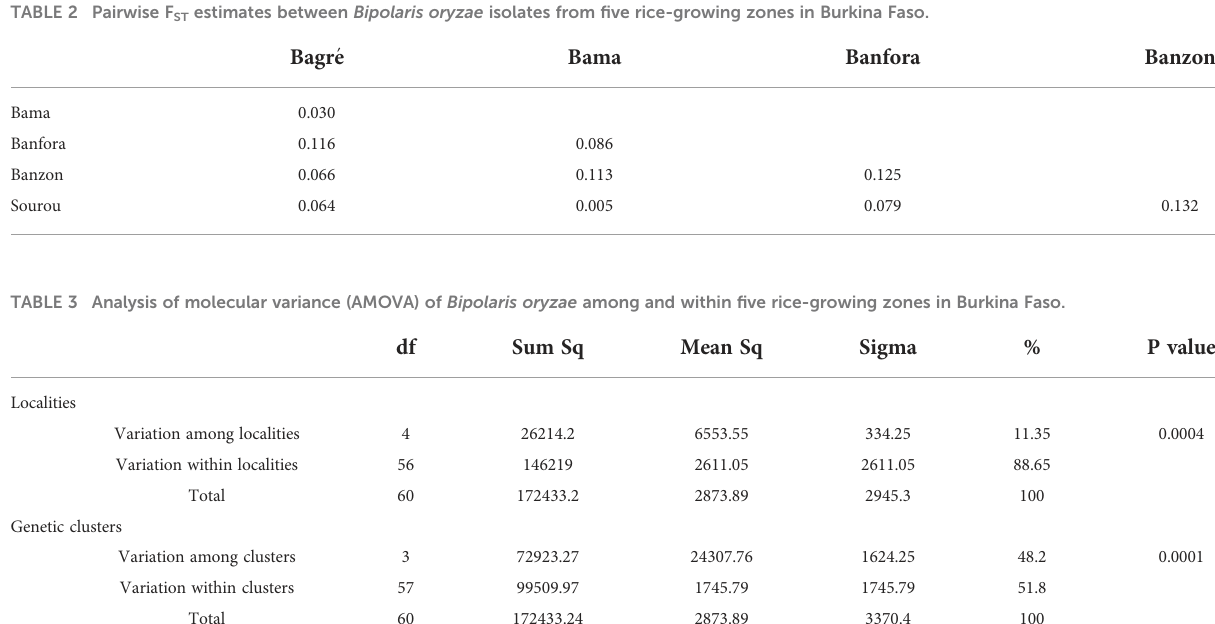
TABLE 2 Pairwise F ST estimates between Bipolaris oryzae isolates from fi ve rice-growing zones in Burkina Faso. Bagre ́